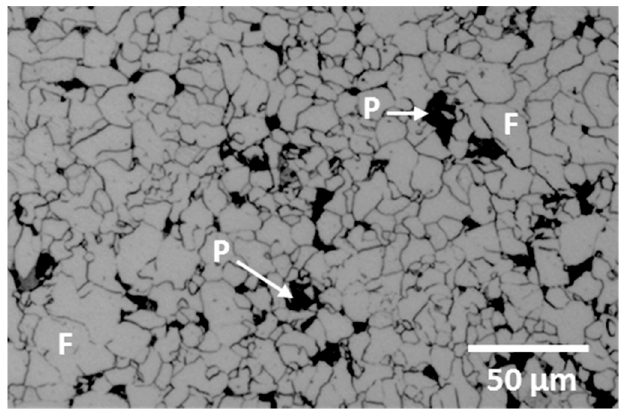
Figure 1. Typical microstructure of X52 steel obtained by optical microscopy.